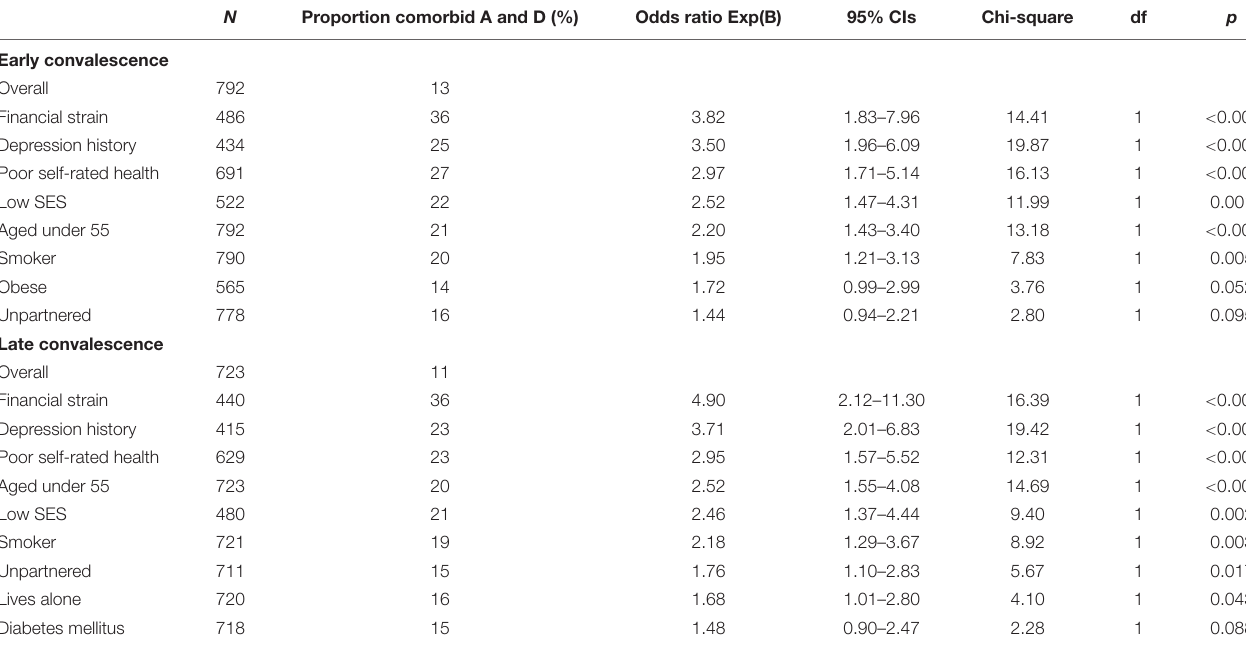
TABLE 4 | Factors associated with comorbid anxiety and depression in early and late convalescence. N Proportion comorbid A and D (%) Odds ratio Exp(B) 95% CIs Chi-square